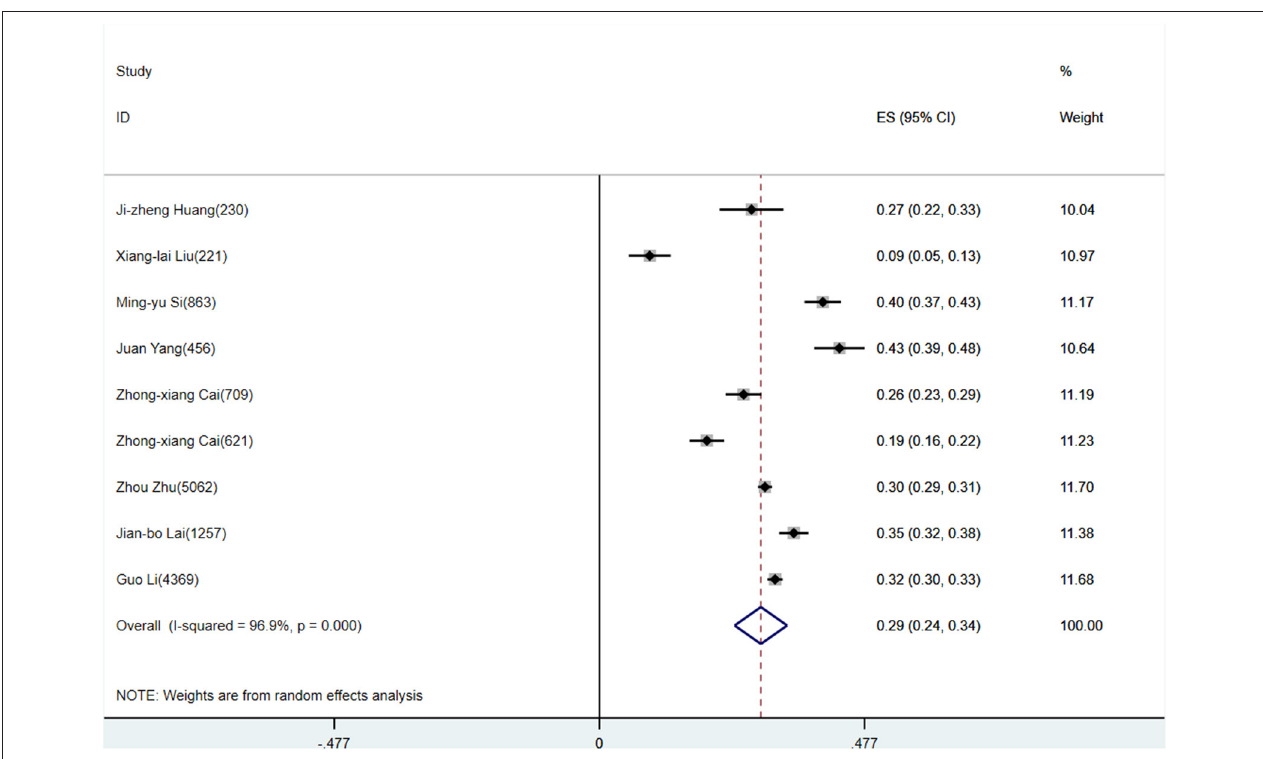
FIGURE 4 | Forest plot of stress disorders prevalence in Chinese healthcare